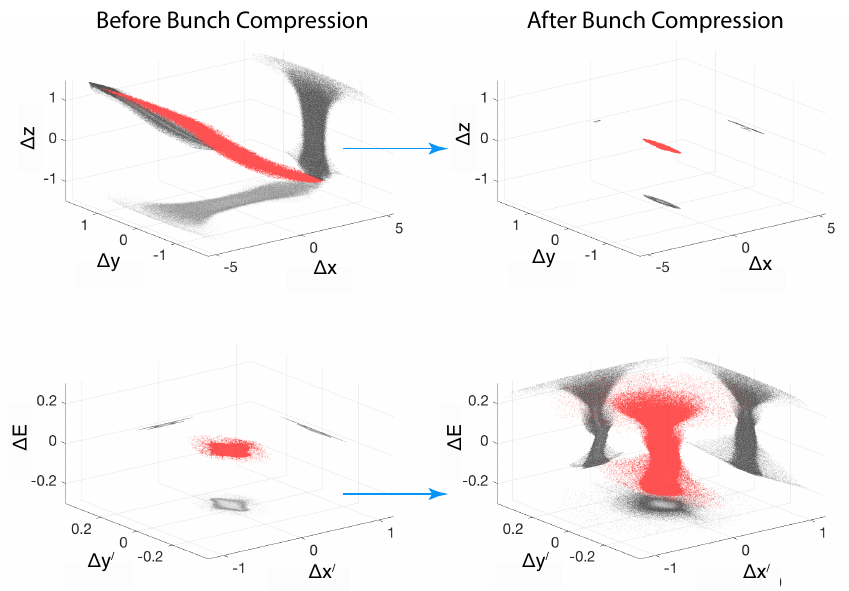
Figure 7. Simulation results showing the 6D phase space evolution of electron bunch compression in FACET-II. Axes are shown with arbitrary units with the same ranges before and after compression to show the